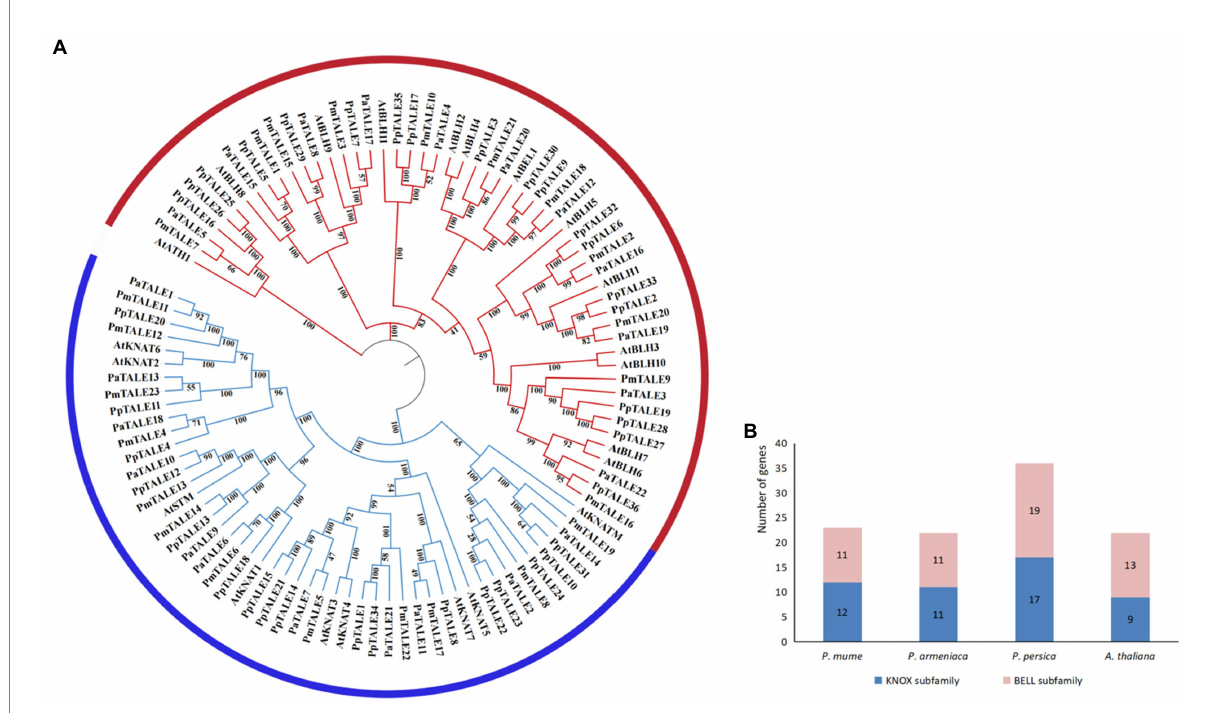
FIGURE 3 Phylogenetic analysis of TALE gene family protein sequences in Prunus mume and other plant species, (A) shows phylogenetic tree of TALE gene family protein sequences in P. mume, Prunus armeniaca, Prunus persica , and Arabidopsis thaliana. PmTALE represents the P. mume TALE protein, PaTALE represents the P. armeniaca TALE protein, PpTALE represents the P. persica TALE protein, and the rest represent the A. thaliana TALE proteins. On the periphery of the figure, the blue semi-circle represents the KNOTTED-like homeobox (KNOX) subfamily, and the red semi-circle represents the BEL1-like homeobox (BELL) subfamily; (B) shows the gene numbers of subfamily in P. mume, P. armeniaca, P. persica , and A.